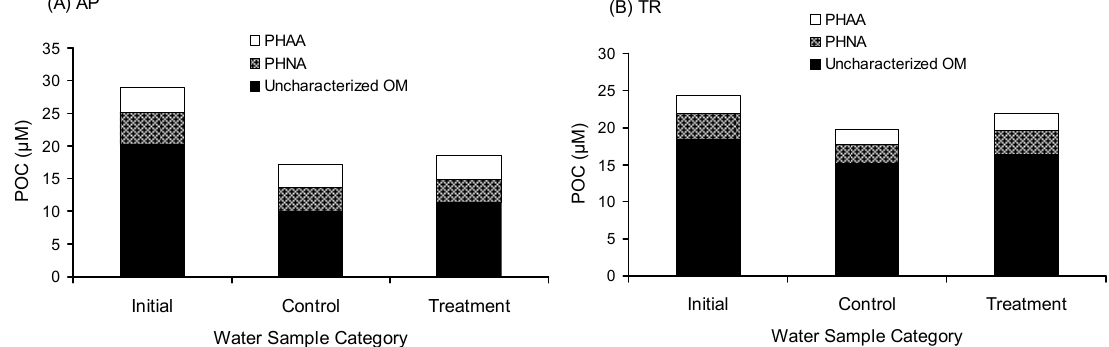
Figure 1. Chemical composition of particulate organic carbon (POC). ( A ) Avery Point station (AP); ( B ) Thames River station (TR). PHAA denotes particulate hydrolysable amino acids. PHNA denotes particulate hydrolysable neutral aldose. Uncharacterized OM denotes uncharacterized organic matter. Initial denotes the field data; treatment denotes samples after two days of rolling; and control denotes samples incubated for two days without rolling.